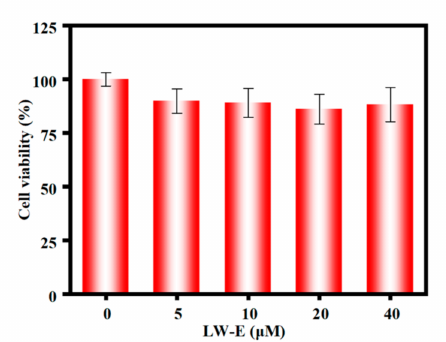
Figure 8. Cytotoxicity assay of H9C2 in the presence of various concentrations of TCF-ether from 0 to 40 µ M for 4